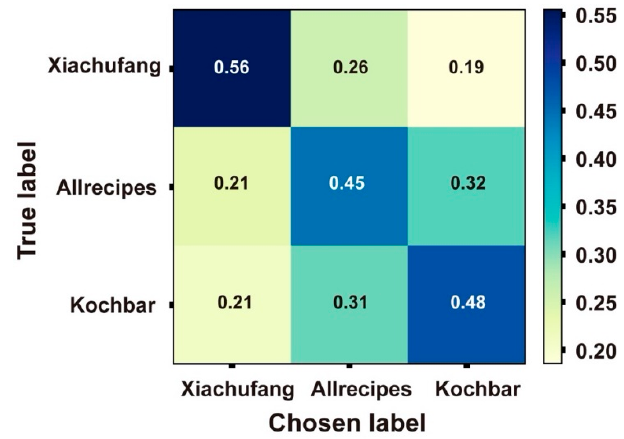
Figure 5. Confusion matrix of participants’ judgements.